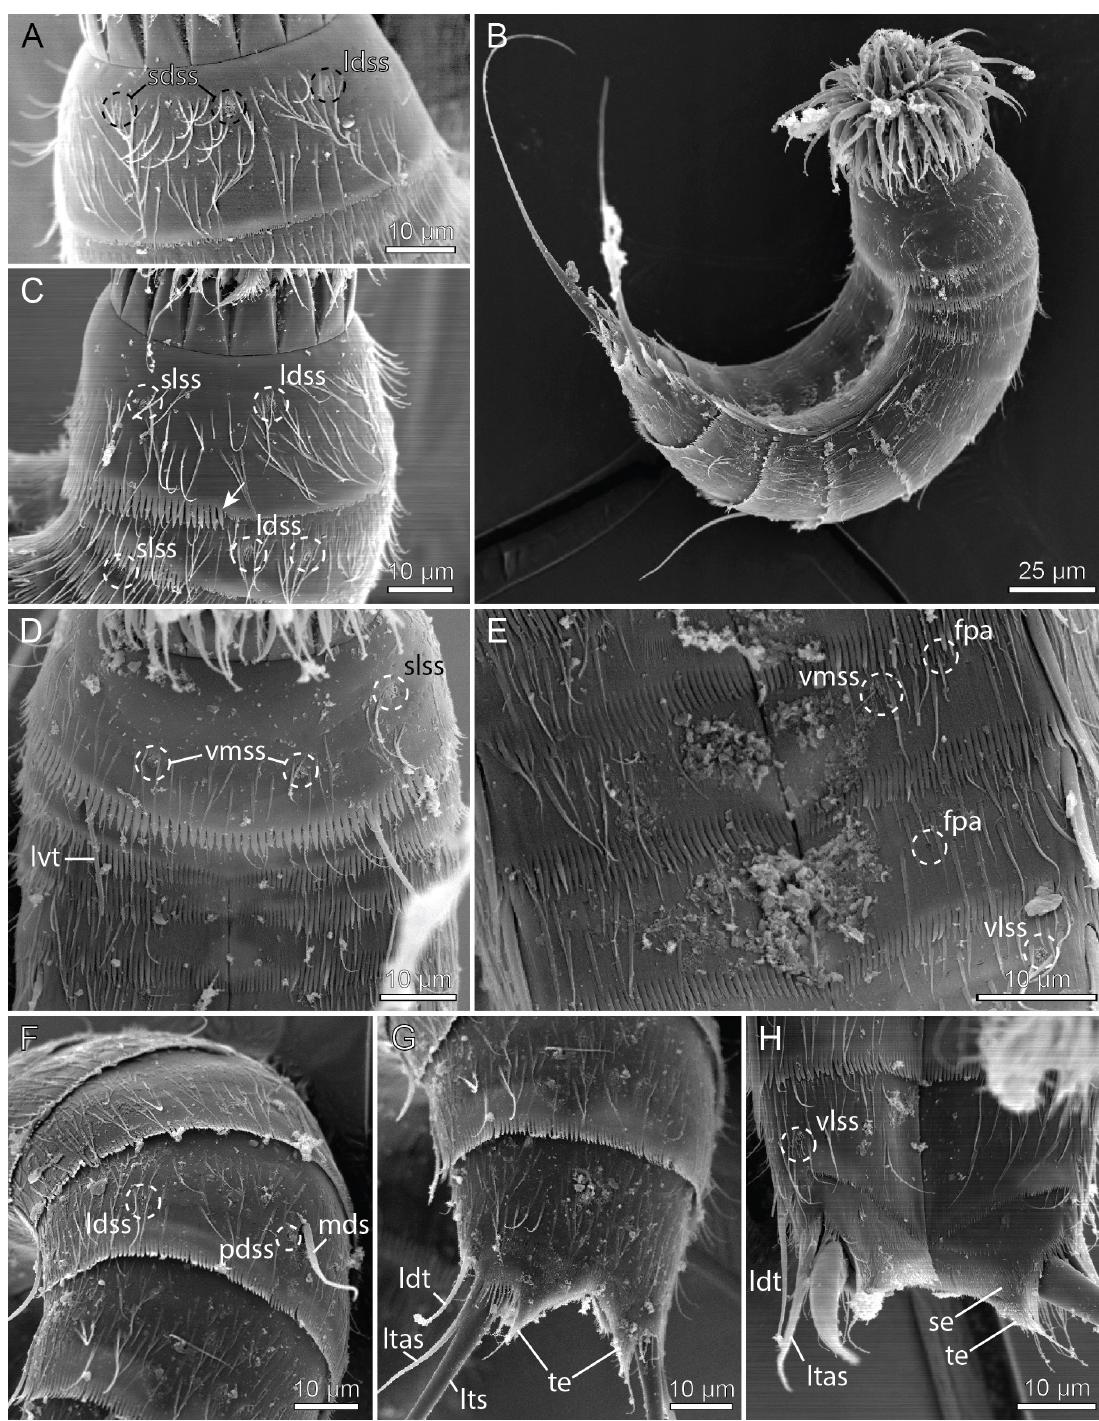
Fig. 17. Light micrographs showing overviews and details of female Echinoderes worthingi Zelinka, 1928 ( MH, personal reference collection). A . Segment 1, subdorsal view. B . Lateral overview. C . Segments 1 to 2, lateral view; note how the lengths of the pectinate fringe tips change in midlateral position (arrow). D . Segments 1 to 4, ventral view. E . Segments 7 to 8, ventral view, showing female sexual dimorphism. F . Segments 7 to 9, laterodorsal view. G . Segments 9 to 11, subdorsal view, showing female sexual dimorphism. H . Segments 10 to 11, ventral view, showing female sexual